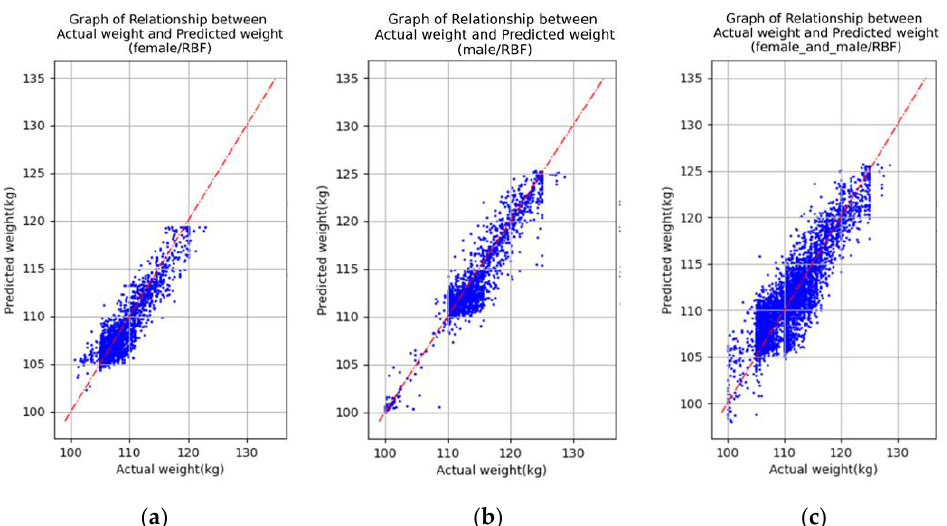
Figure 6. Graph of relationship between actual weight and predicted weight using RBF network. ( a ) is sows, ( b ) is boars, ( c ) is mixture of sows and boars. Table 4. Prediction performance of multilayer RBF networks on different gender.